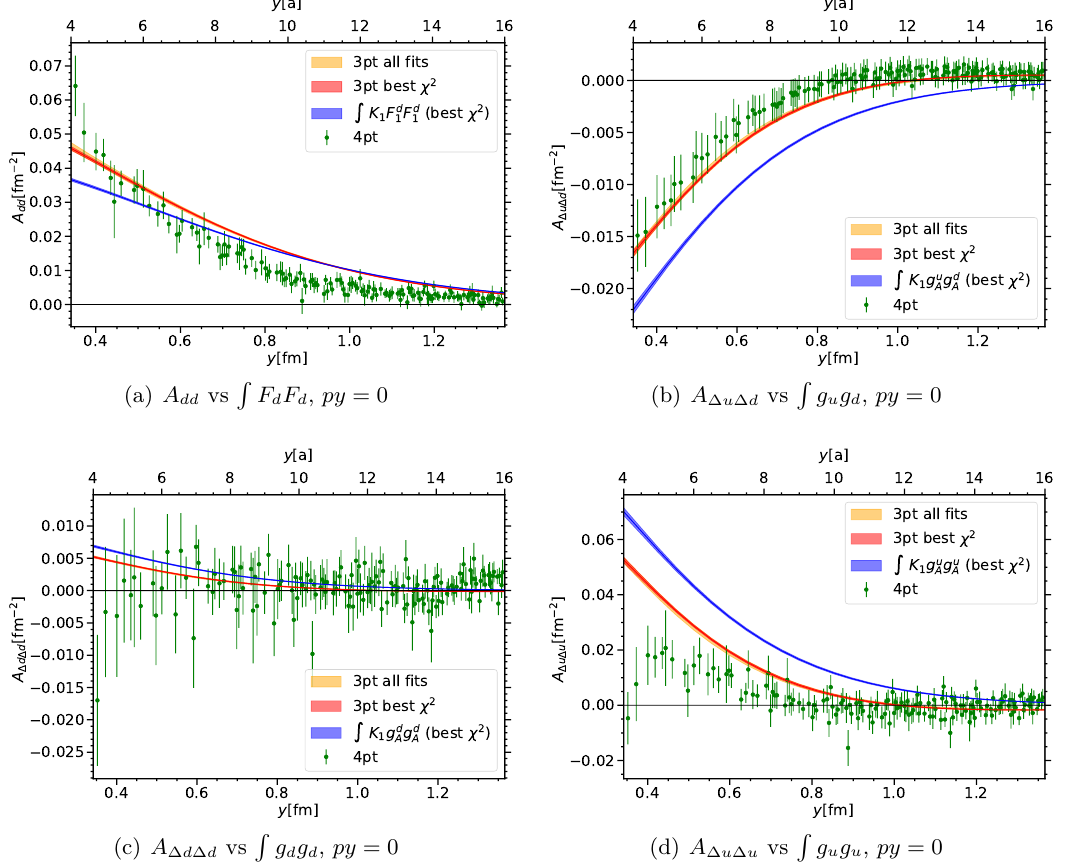
Figure 28 . The twist-two functions A dd (a), A ∆ u ∆ d (b), A ∆ d ∆ d (c) and A ∆ u ∆ u (d) compared to the corresponding form factor integral (5.13) or (5.14). The orange band again represents the envelope of the error bands for the different fits. The blue curve shows again the integration result of the first term in (5.13) or